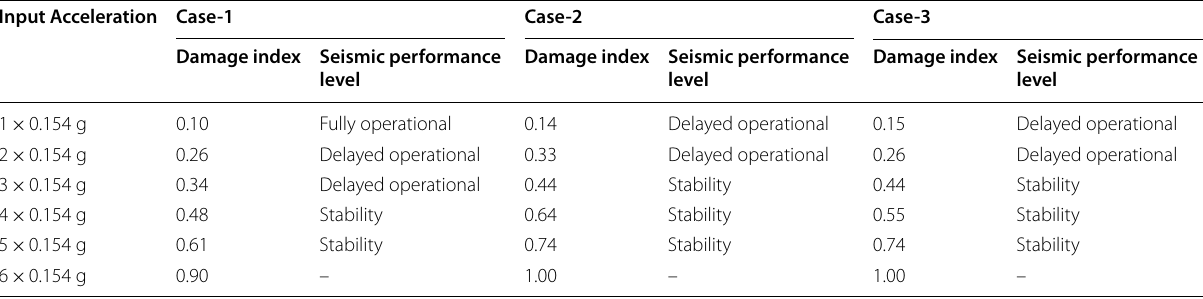
Case-1: longitudinal reinforcement ratio 1.61, transverse reinforcement ratio 0.6; Case-2: longitudinal reinforcement ratio 1.61, transverse reinforcement ratio 0.4; Case-3: longitudinal reinforcement ratio 0.81, transverse reinforcement ratio 0.6.